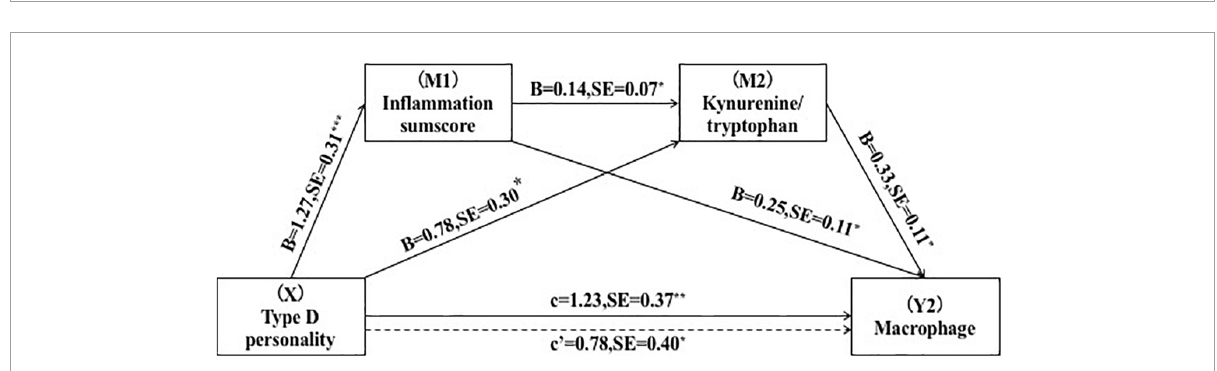
FIGURE3 Serial-multiple mediation of inflammation and kynurenine/tryptophan ratio in the relationship between Type D personality and macrophage. * p < 0.05, ** p < 0.01.